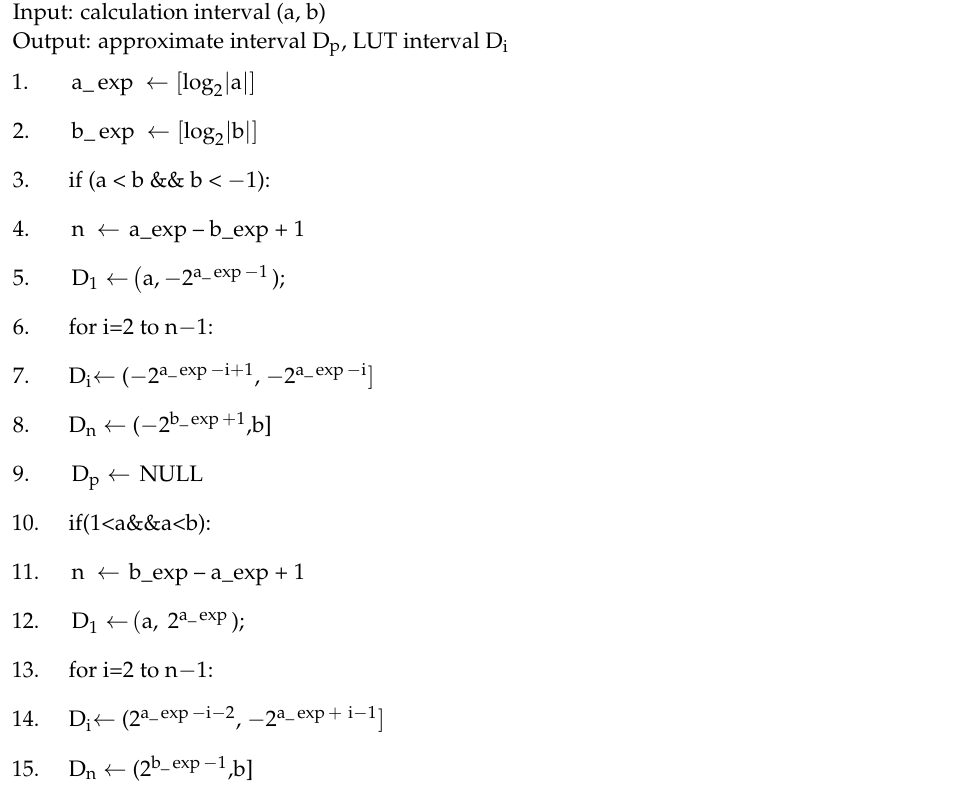
Algorithm 3. Interval partitioning